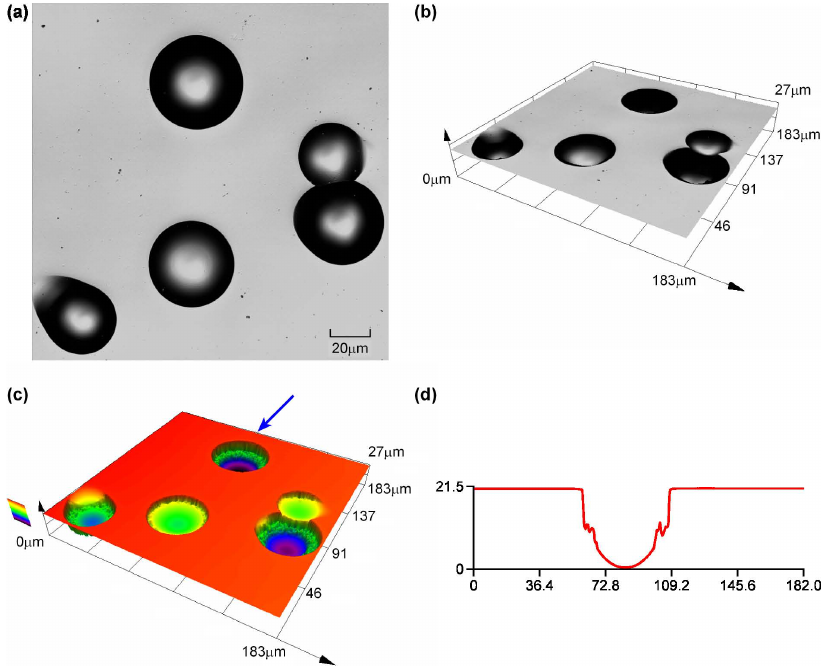
Fig. 1. Example of 3-D visualisation of tracks from data obtained with a × 50 objective showing the distribution of single isolated tracks and two coalescing tracks. (a) shows the view from the top surface, (b) shows a side view and (c) the corresponding height encoded colour image with red being the top, through yellow, blue, green to purple being the deepest. (d) shows depth profile (in µm) for the deepest track (blue arrow in c) which has a measured depth of